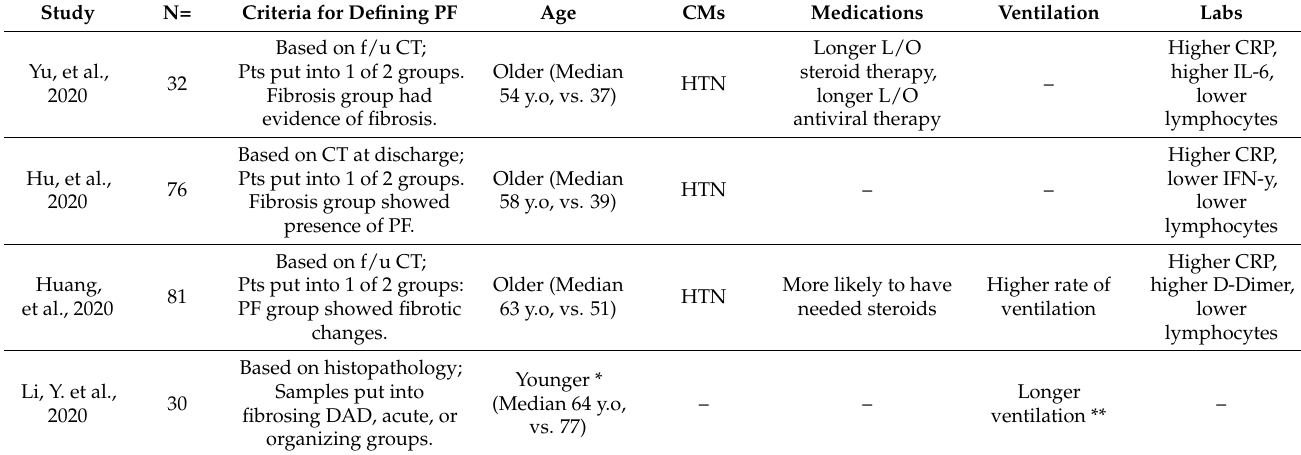
Table 1. Associations with post-Covid PF. Abbreviations: L/O = length of, LOS = length of stay, f/u = follow-up, RR = respiratory rate, Sx = symptoms, CMs = comorbidities, pts = patients. * = compared to those with acute DAD, ** = compared to all other patterns of DAD. All associations are p <